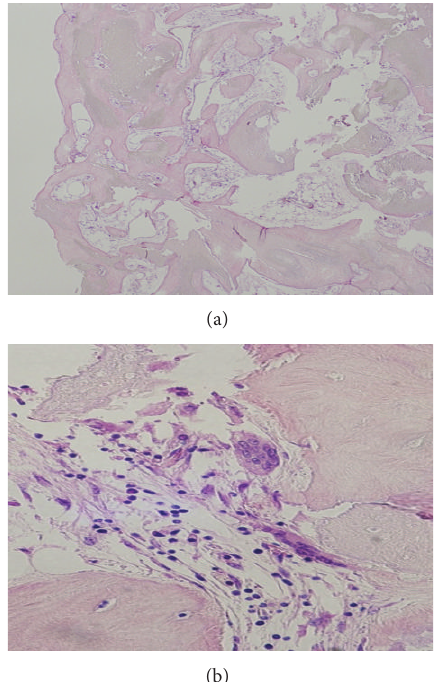
Figure 5: Pathological findings 1 (H-E, × 40 and 400): aggregation of shadow cells and surrounded bone tissue were observed. At the stroma, multinuclear giant cells are sparsely observed, and there was no infiltration of eosinophils. Old calcifying epithelioma with ossification was